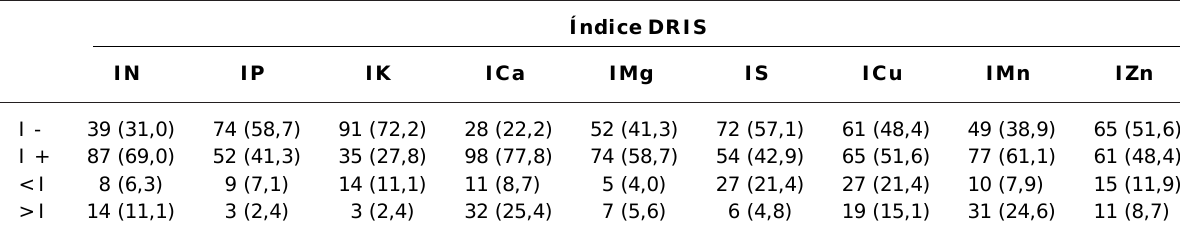
Quadro 5. Número e freqüência de amostras que apresentaram índices DRIS negativos (I-) e